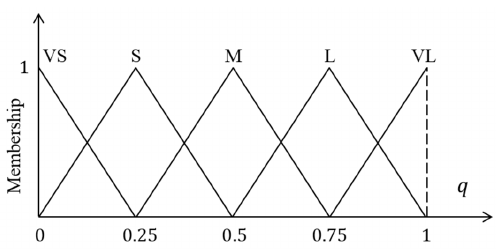
Figure 11. Fuzzy sets of consequent variables. Table 3. Parameters of fuzzy sets of antecedent variables.